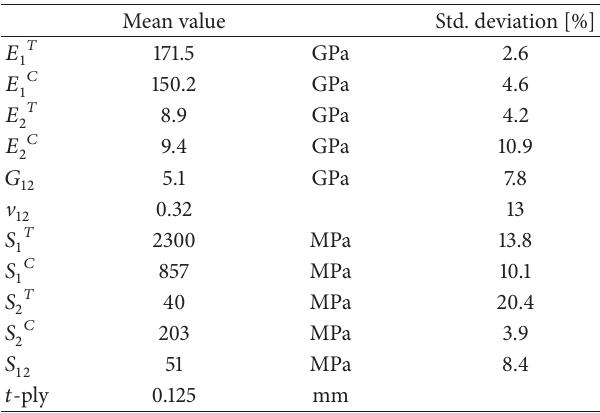
Table 2: Measured material properties of UD prepreg Hexcel